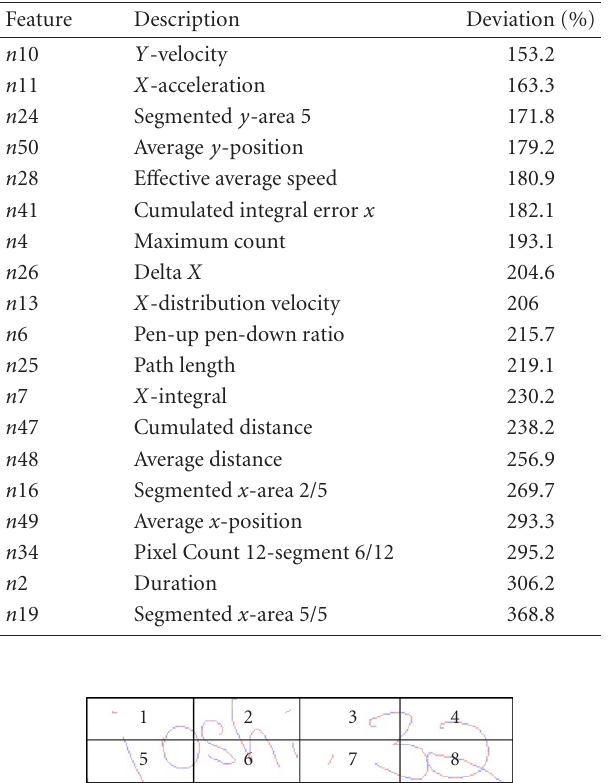
Table 4: Features showing a high intrapersonal variability for N = 6 with the semantic class being signature.